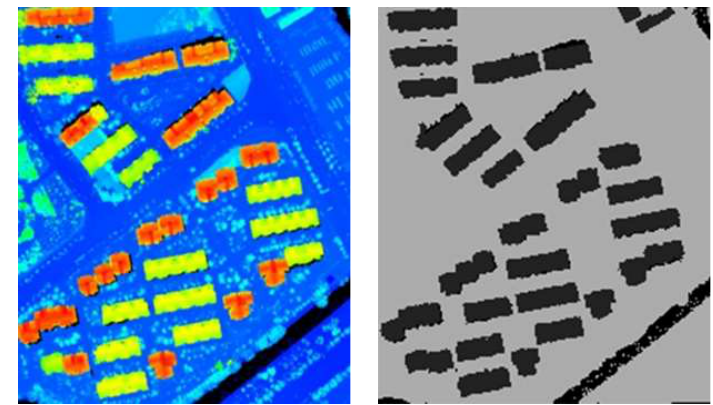
Figure 6. HDR 1 elevation coloration and manual extraction results.